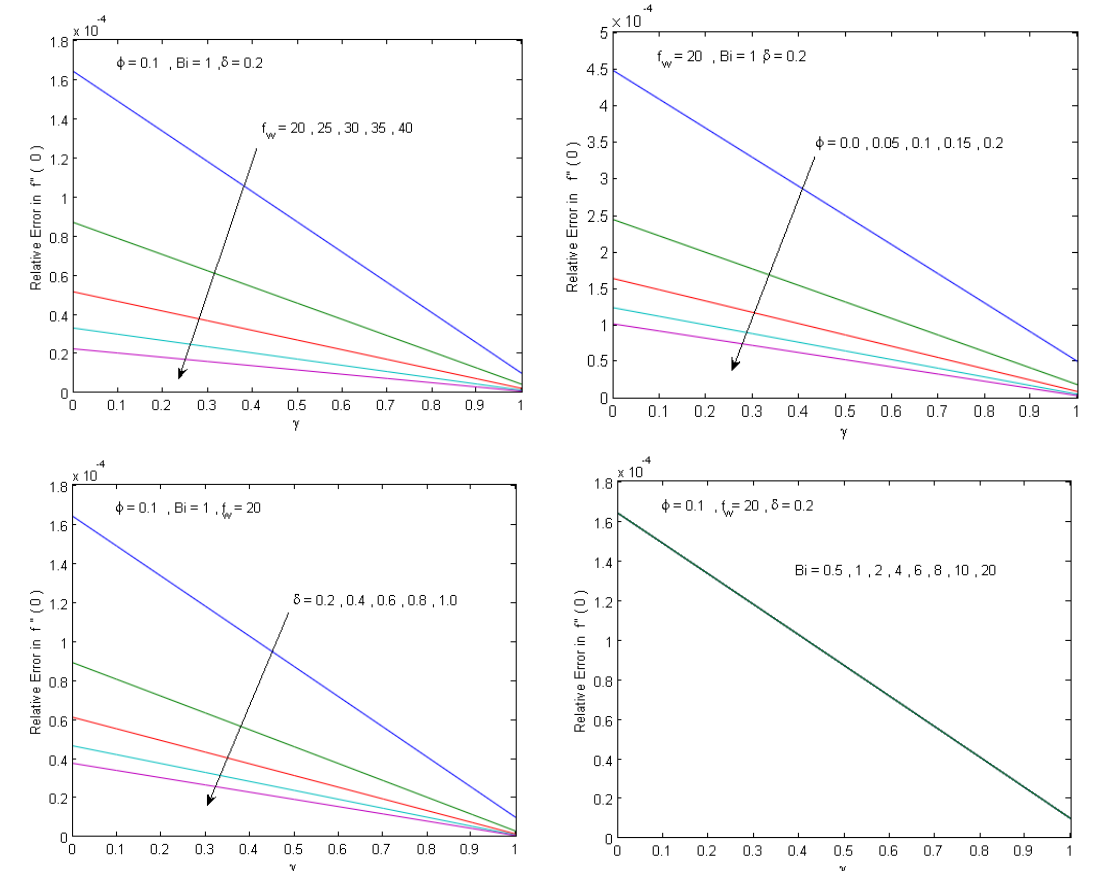
f , , Bi , and on the maximum absolute error w (cid:48) ( w 0 ) .